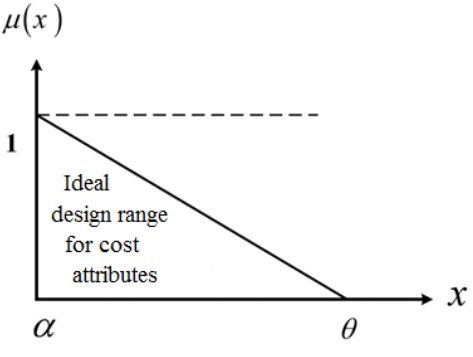
Figure 5. Ideal design range for cost attributes